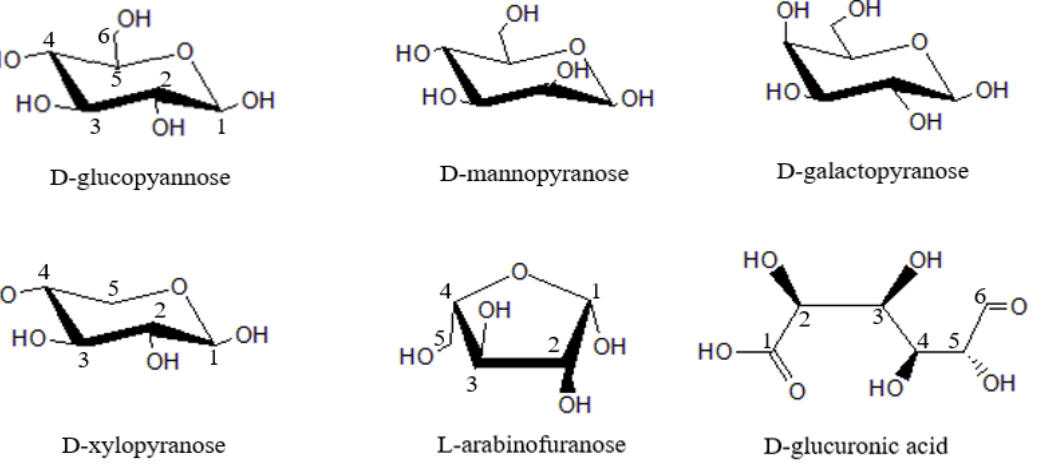
Figure 1. Main structural units of hemicellulose.